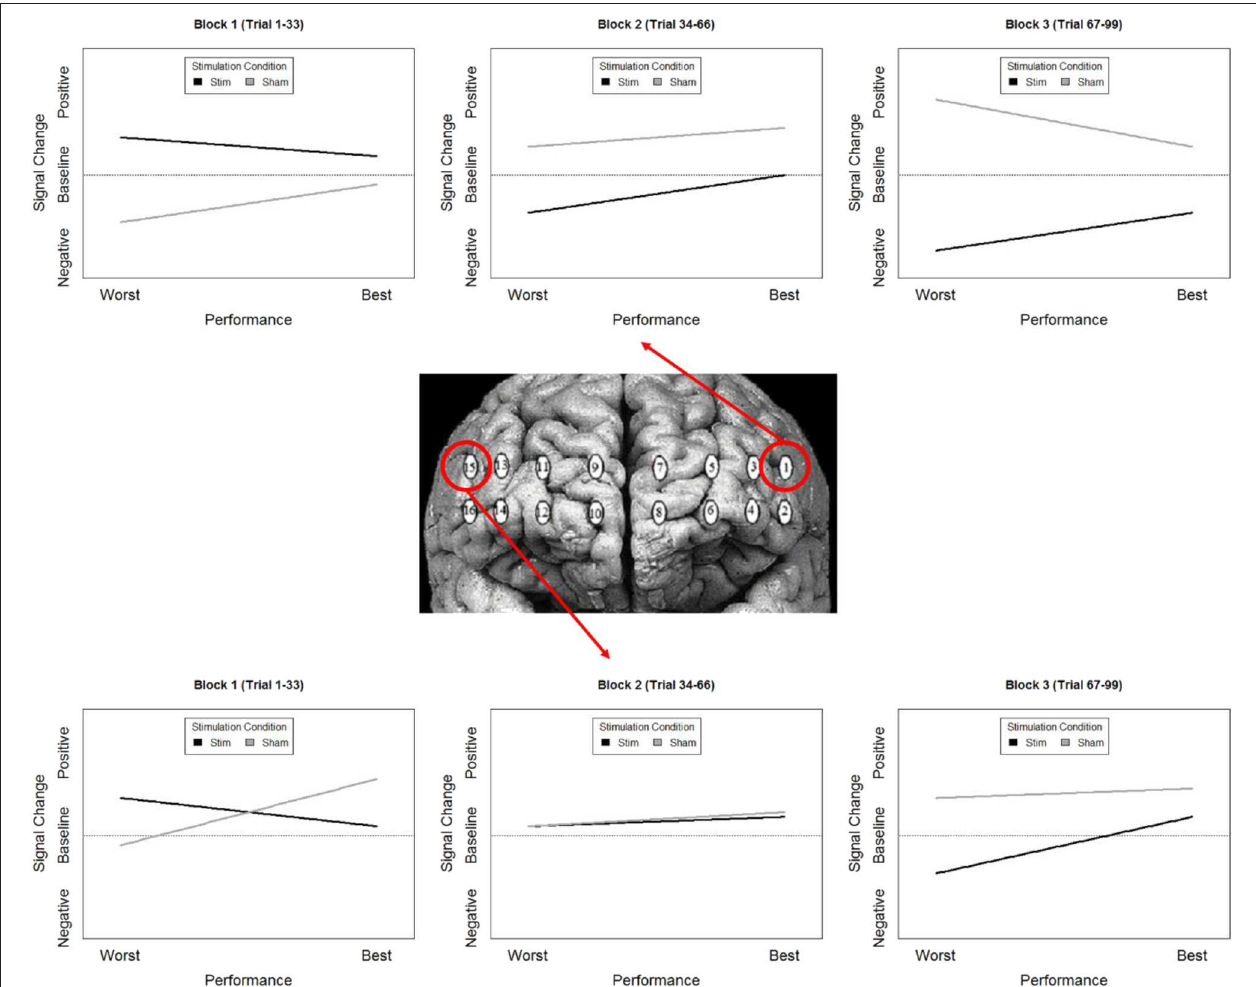
FIGURE 10 | Simplified representation of changes in the relationship between Oxy signal change and performance in Optodes 1 and